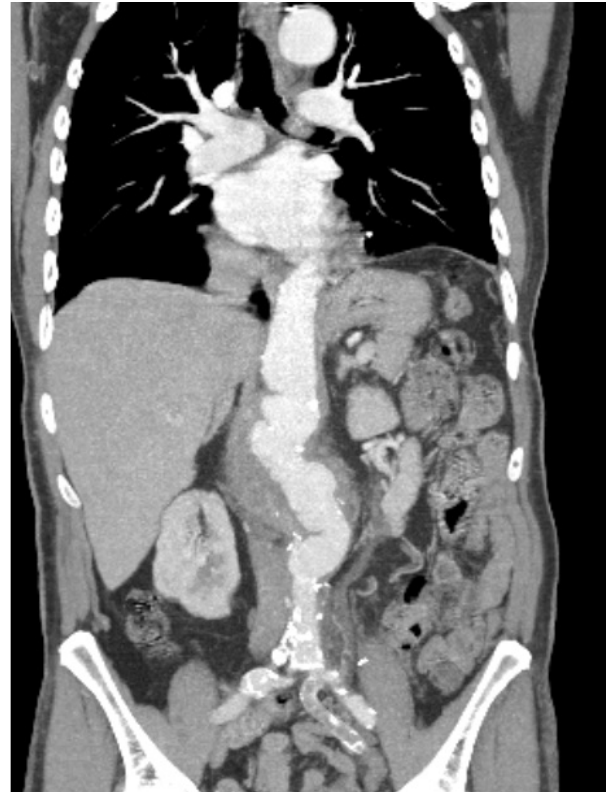
Fig. 5 - Preoperative computed tomography angiography of thoracoabdominal aneurysm in the patient with severe coronary artery